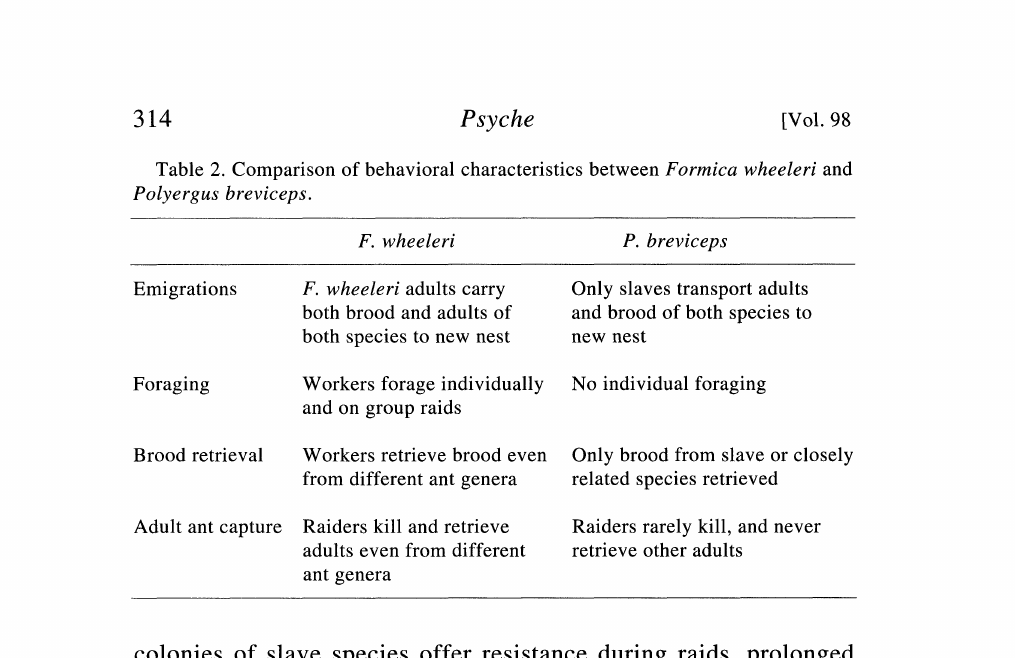
Table 2. Comparison of behavioral characteristics between Formica wheeleri and Polyergus